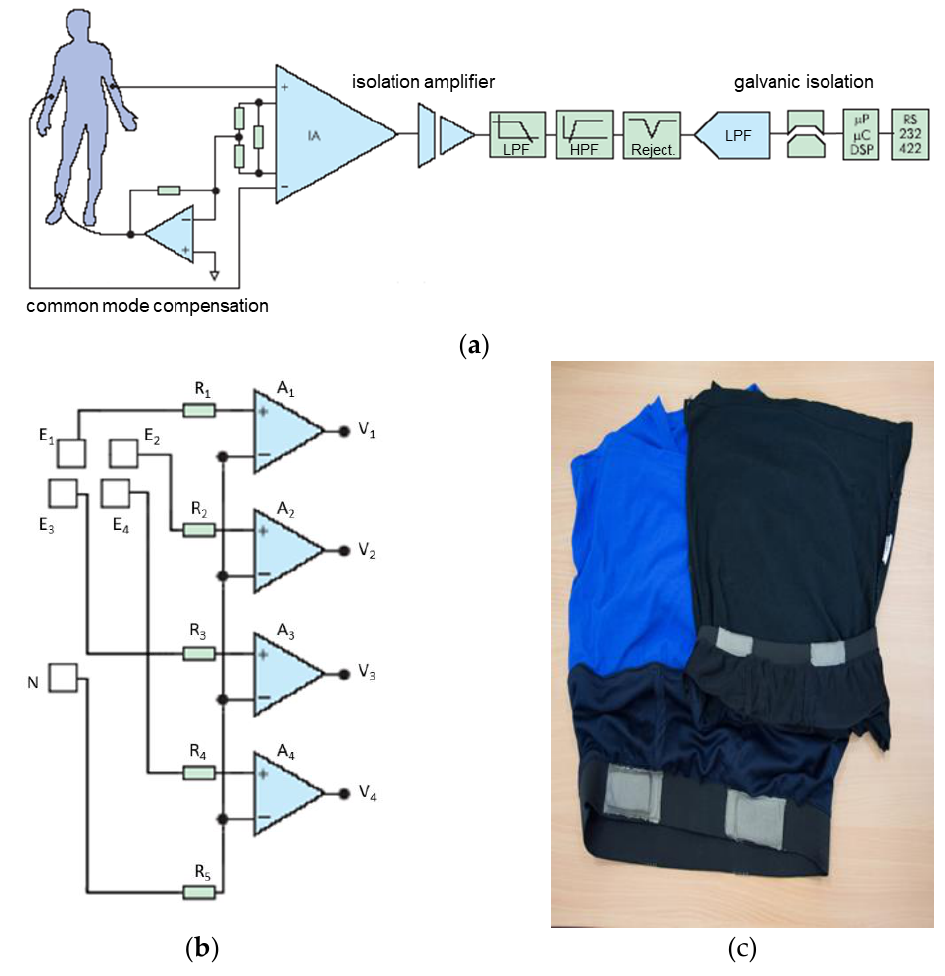
Figure 3. Schemes for recording a standard ECG ( a ) and non-contact ECG ( b ), clothes with electrodes were made of an electrically conductive fabric ( c ).